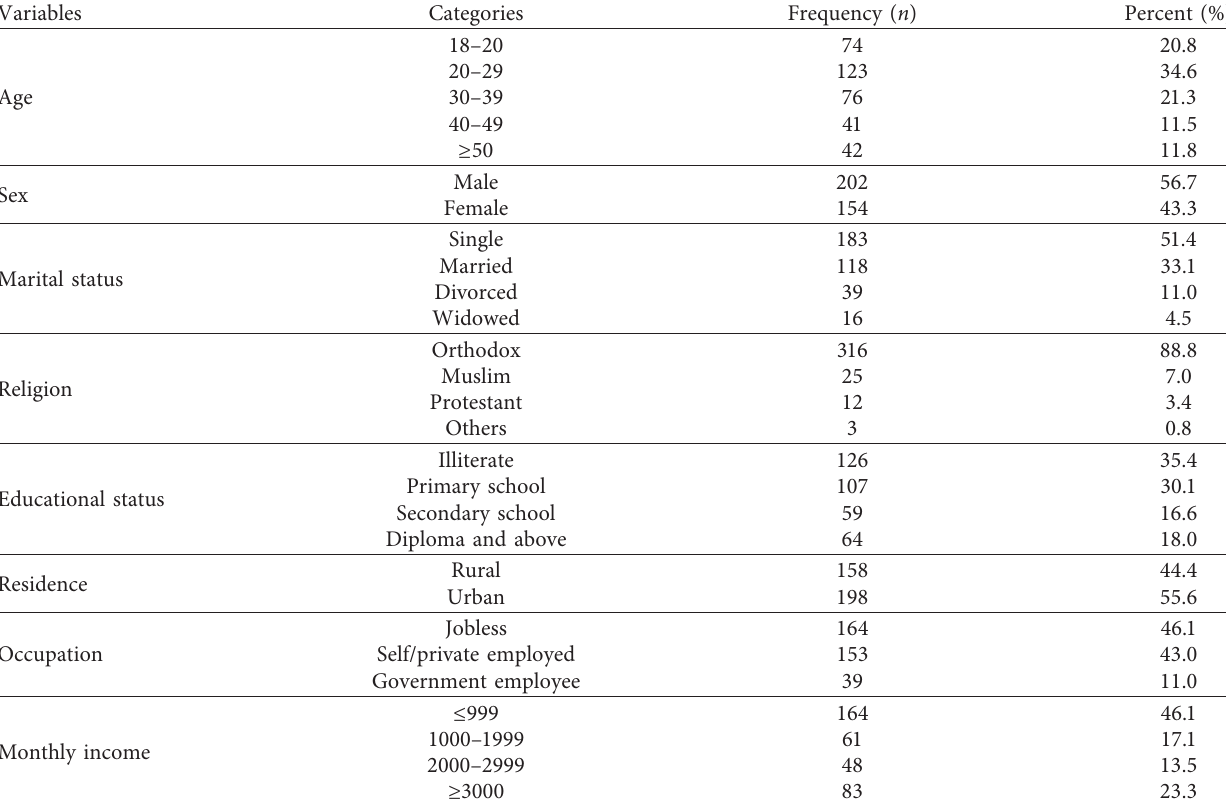
Table 1: Sociodemographic characteristics of epileptic patients at UGCSH, Ethiopia, 2019 ( n � 356).